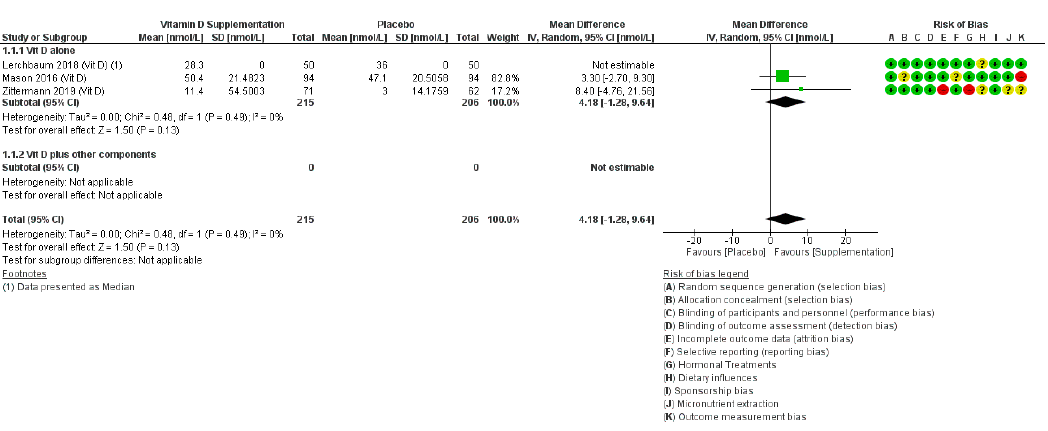
Figure 4. Forest plot assessing effects of increasing vitamin D on free testosterone (nmol/L). Vit D,